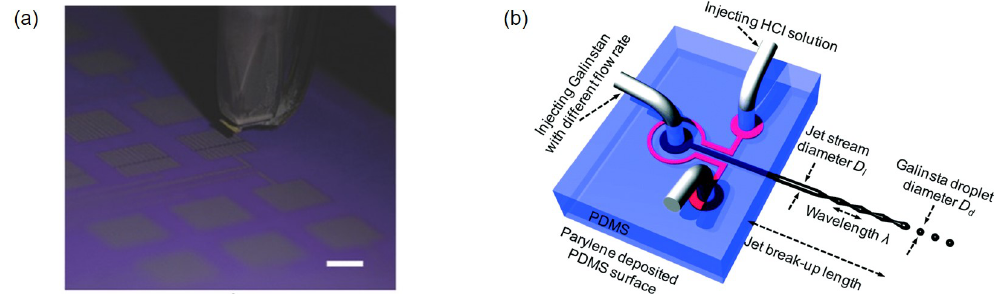
Figure 5. ( a ) Liquid metal patterns are made by using a commercial inkjet printer with liquid metal nanodroplets dispersed ink. Scale bar is 5 mm in length. Reproduced with permission from [55]; published by John Wiley and Sons, 2015. ( b ) An inkjet nozzle made by MEMS fabrication process generating liquid metal microdroplets with the aid of the Rayleigh–Plateau instability.